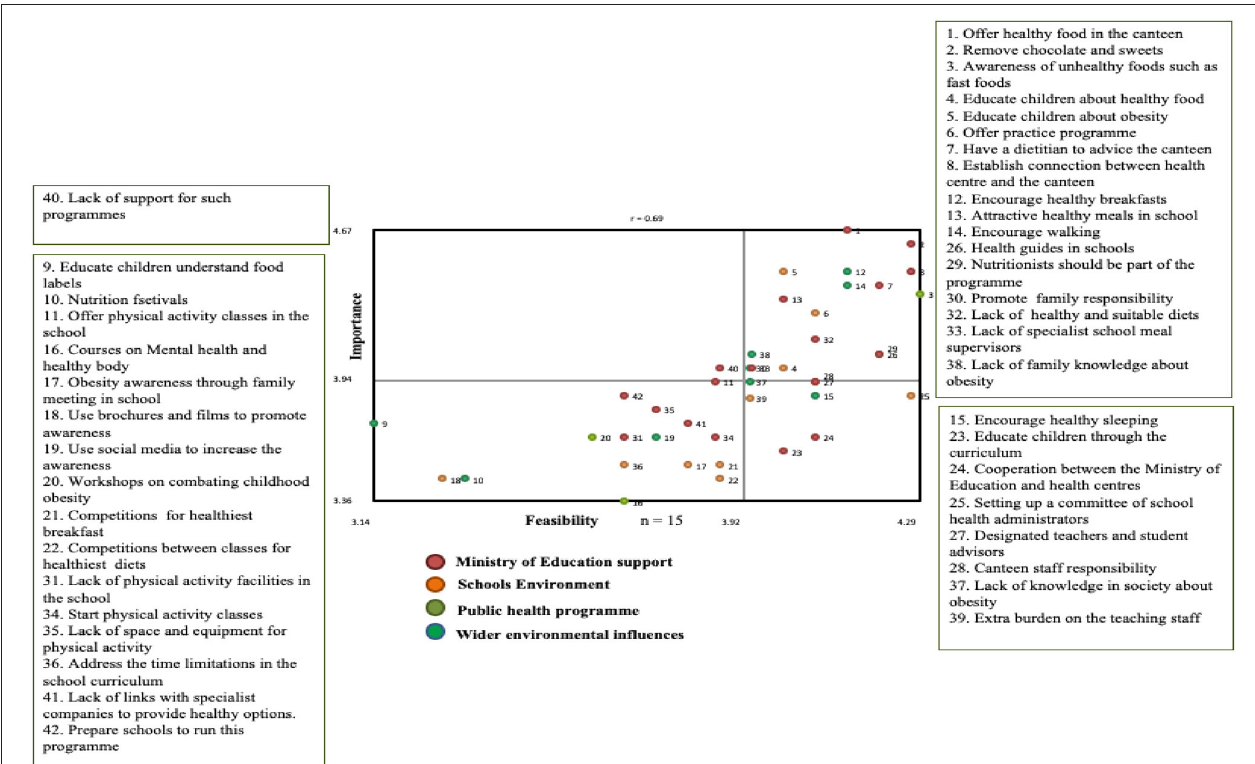
FIGURE 2 | Go-zone map based on adults’ perspectives on the content of a school-based